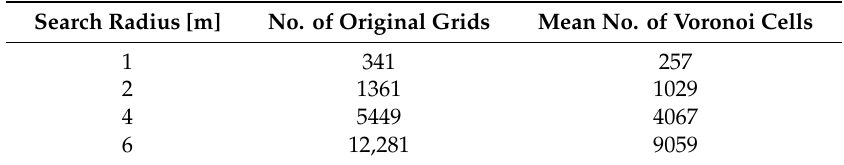
Table 2. Comparison of the number of the Voronoi cells with the number of original grids in the search circle.